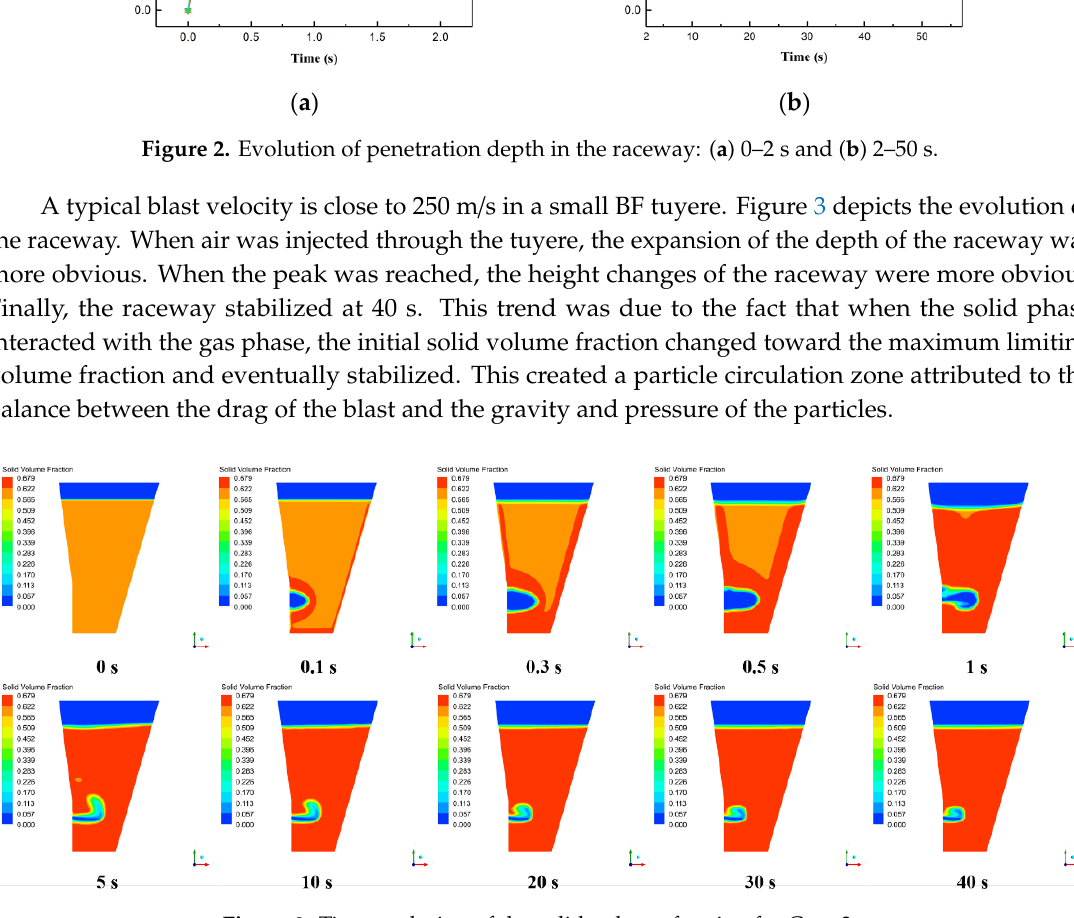
Figure 3. Time evolution of the solid volume fraction for Case 3.